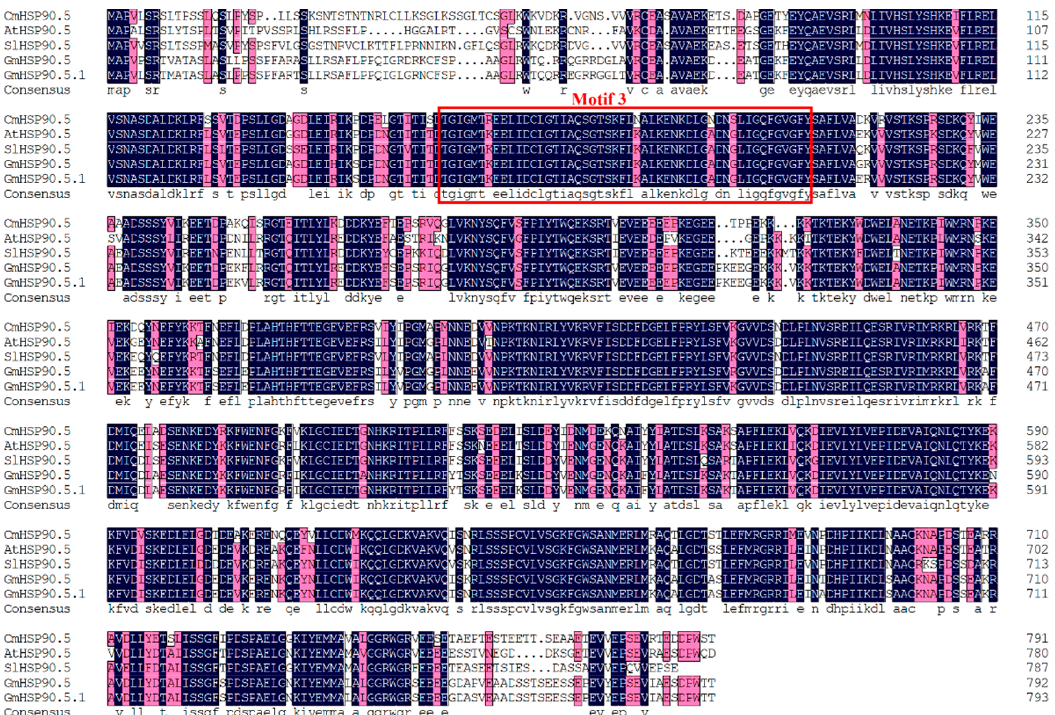
Figure 1. Amino acid alignment among HSP90.5 proteins. Red box includes the conserved ATPase-domain in HSP90.5 proteins.